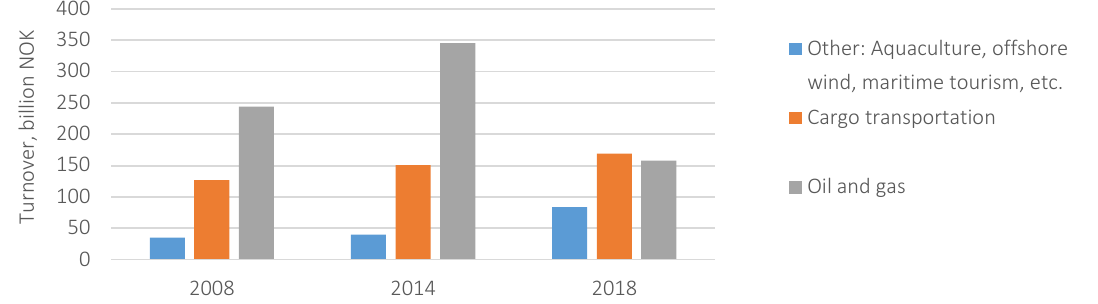
Figure 3. Turnover generated from different market segments